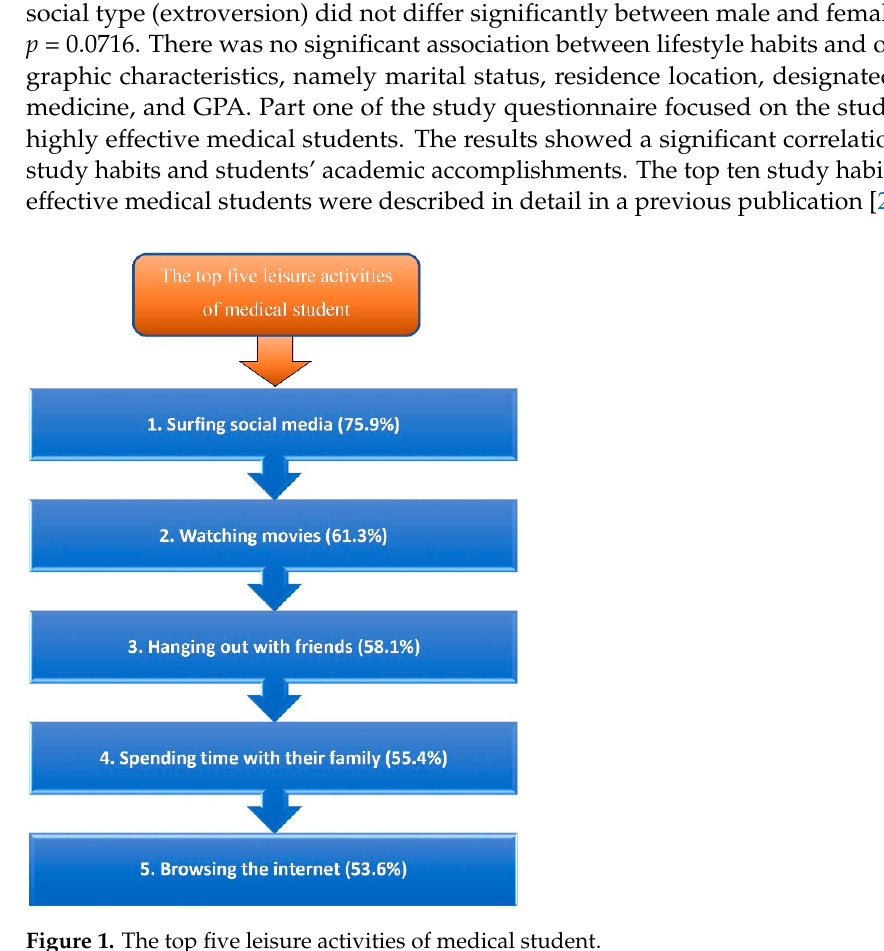
Figure 1. The top five leisure activities of medical student.